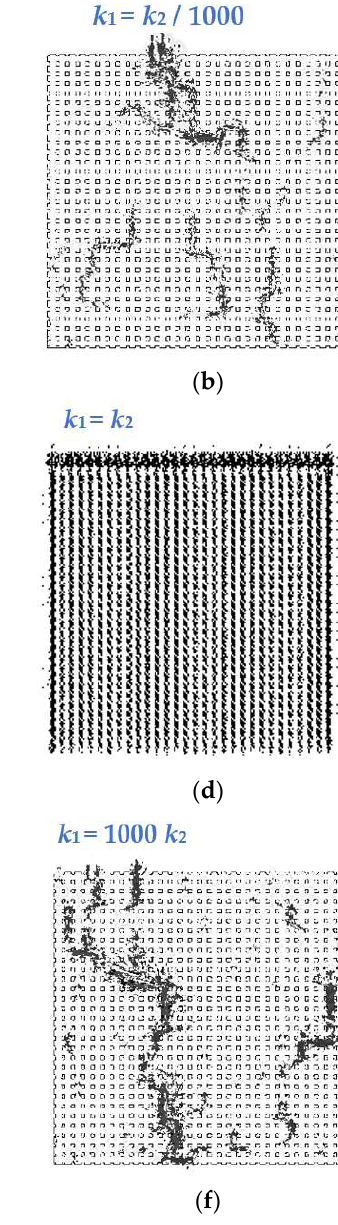
= k / 1000, ( c ) k = k / 10, ( d ) k = k = 10 k = 1000 k 1 2 1 2 1 2 , ( e ) k 1 2 , ( f ) k 1 2